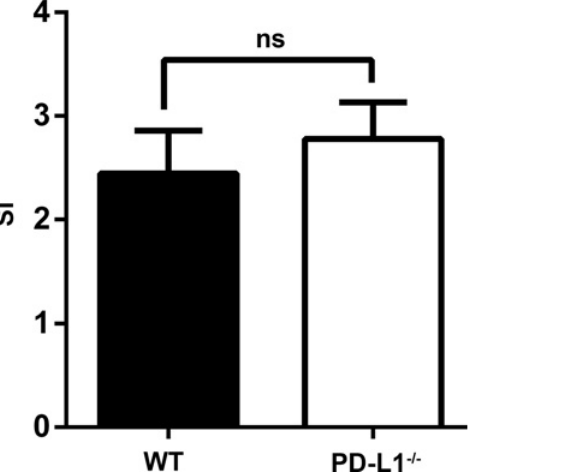
Fig 1. Influence of PD-L1 deficiency on insulin secretion in islets during glucose stimulation. Insulin release was measured using the insulin enzyme-linked immunosorbent assay kit, and the SI was calculated as the ratio of insulin release under high and low glucose conditions. Experiments were performed in triplicate, and the results represent three independent experiments. There was no difference in insulin secretion between the islets from WT and PDL1- deficient mice (ns indicates no significance).